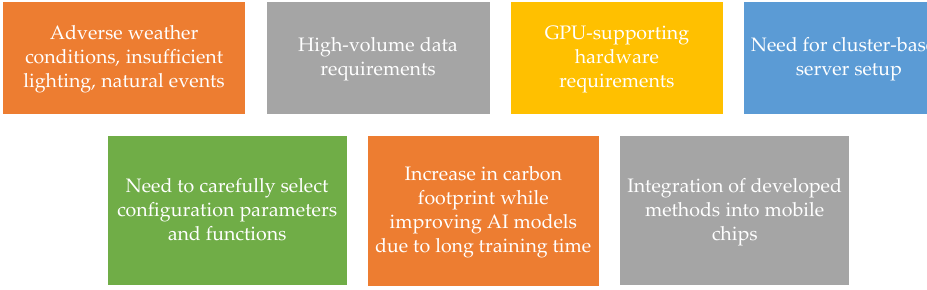
Figure 5. Challenges of Computer Vision Studies .